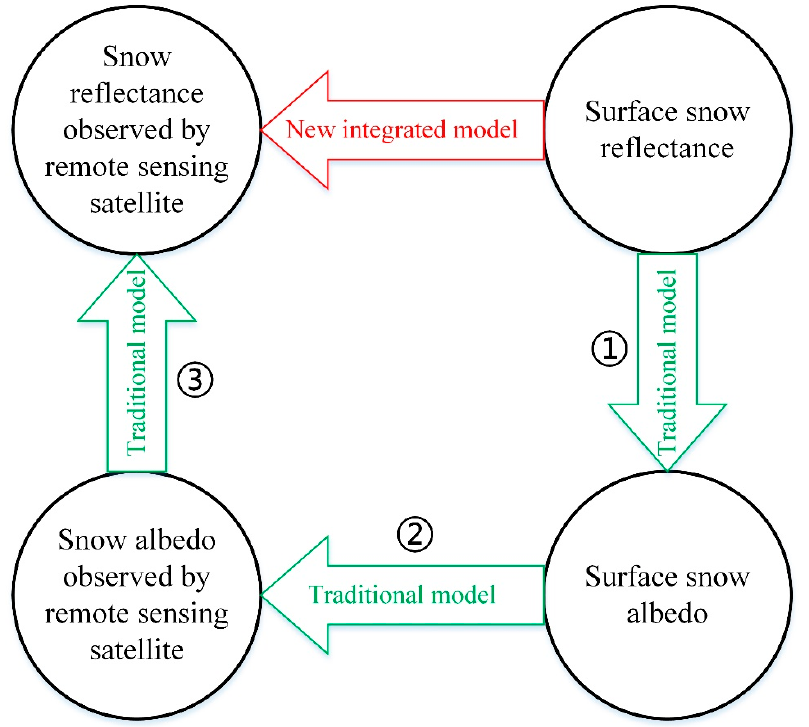
Figure 12. Comparison of satellite remote sensing observations simulated by the new integrated model and the traditional simulation method (the green arrows represent the traditional simulation model steps, and the red arrow represent the single step in the new integrated model).